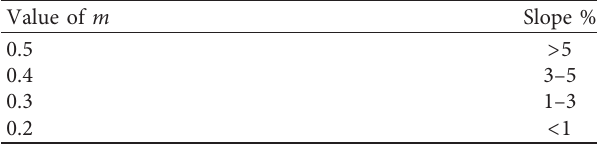
Table 3: Values of support practice factor (P) in terms of